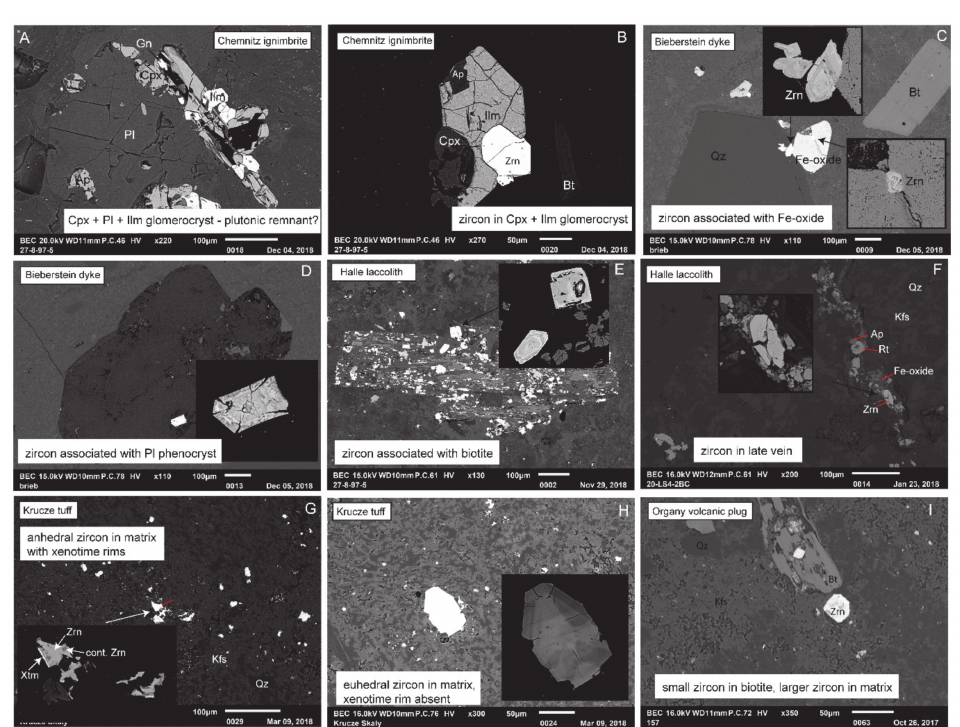
Figure 4. Back-Scattered electron (BSE) images showing typical occurrences of zircon in the studied rhyolites and corresponding images of zonation in the zircons. ( A , B ) BSE images of Chemnitz ignimbrite commonly showing plagioclase-pyroxene plus accessory glomerocrysts; ( C ) Bieberstein dyke, with zircon being commonly associated with Fe-oxides; ( D ) Bieberstein dyke with zircon included in altered plagioclase porphyrocryst; ( E ) Halle laccolith-zircon in biotite and matrix; ( F ) Halle laccolith-zircon associated with late veins rich in accessory phases and Fe-oxides; ( G ) Krucze sample with abundant anhedral zircon with xenotime rims; ( H ) Krucze sample with euhedral / subhedral zircon without xenotime rims; ( I ) Organy lava dome showing diverse zircon sizes within and